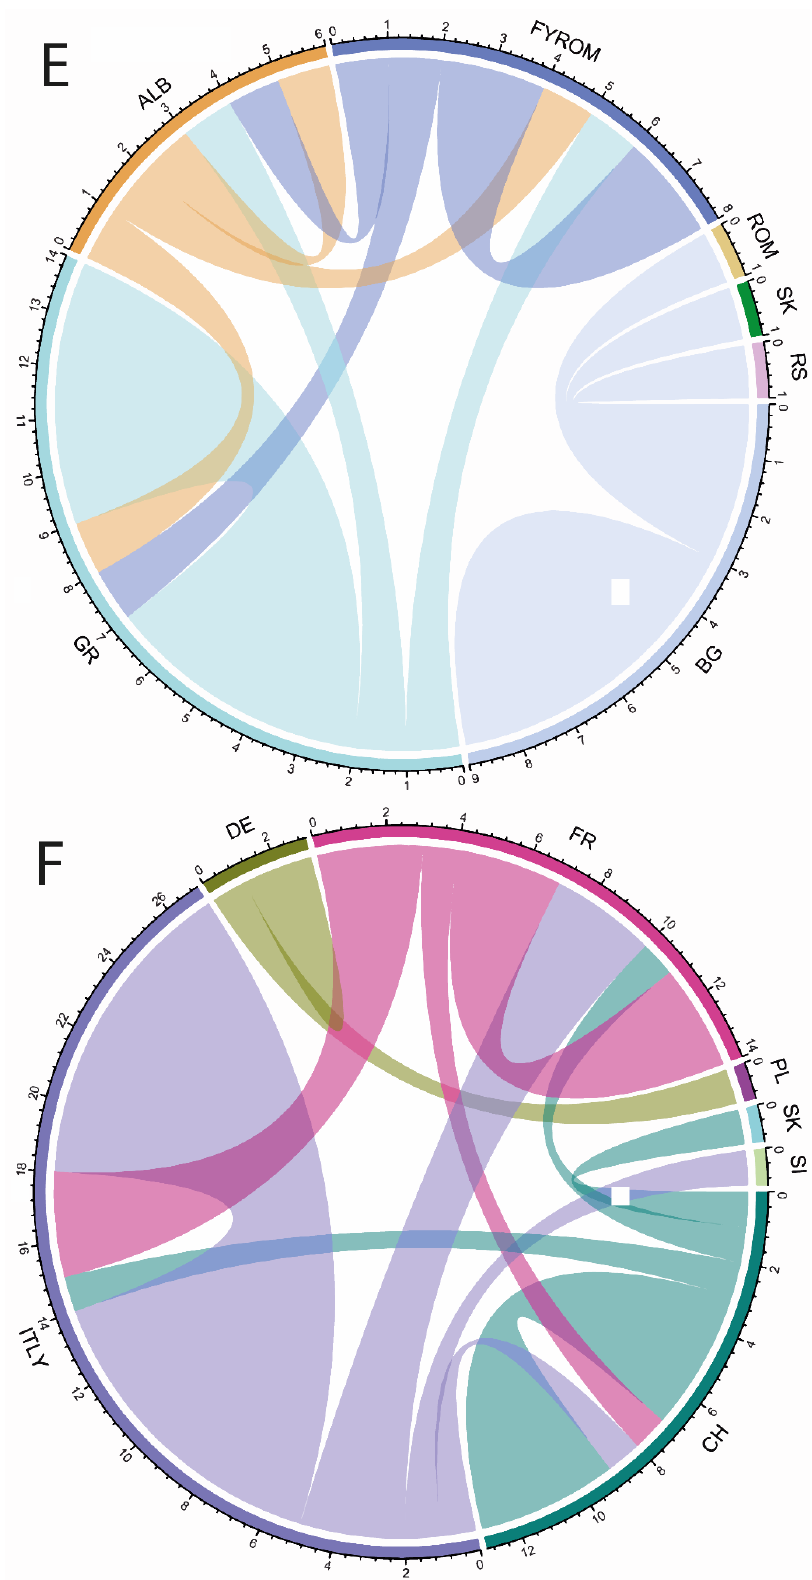
Figure A8. International collaboration between study areas: ( A ) Studies from the Apennines and the Alps are grouped in “Alps”, Belar. = Belarus; and countries belonging to the Carpathians ( B ); International collaboration between countries belonging to the Dinaric Alps ( C ) and Scandinavia ( D ); International collaboration between countries belonging to the Balkans ( E ) and the Alps ( F ).